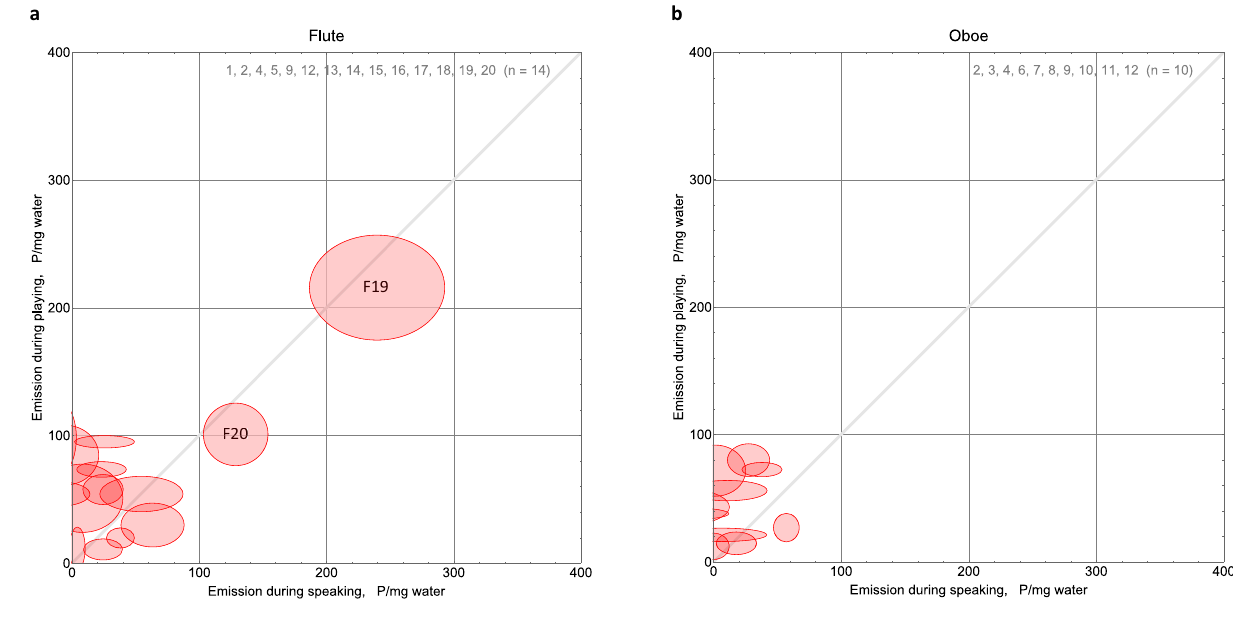
Figure 7. Particle emission per mg water emission during flute ( a ) or oboe ( b ) playing vs. during speaking. Gray lines indicate equal particles-per-water ratios for both tasks. Oboe playing tends to produce larger particles-per-water ratios than speaking while flute playing does not seem to: In diagram ( b ) more ellipses are located above the grey line than on or below it. The ellipses above the line indicate higher ratios from instrument playing than from speaking. In diagram ( a ) the distribution of ellipses with respect to the grey line is almost neutral. F19 and F20 are exceptional dry high emitters.